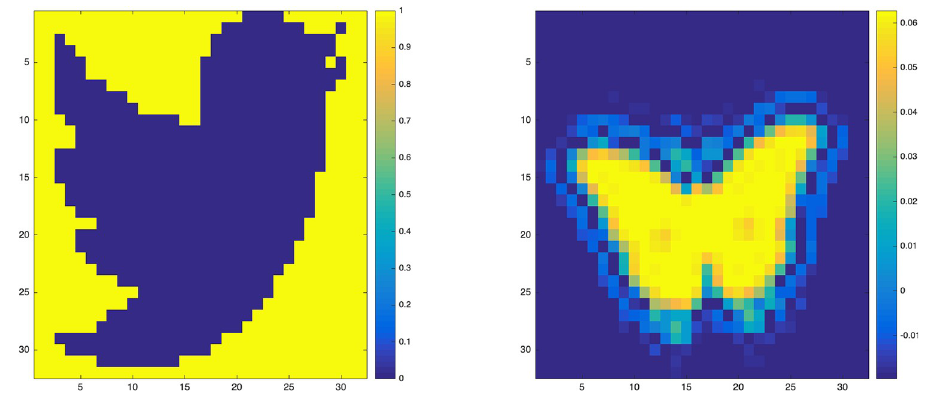
Fig 2. Simulated example. The true parameter images B 0 .